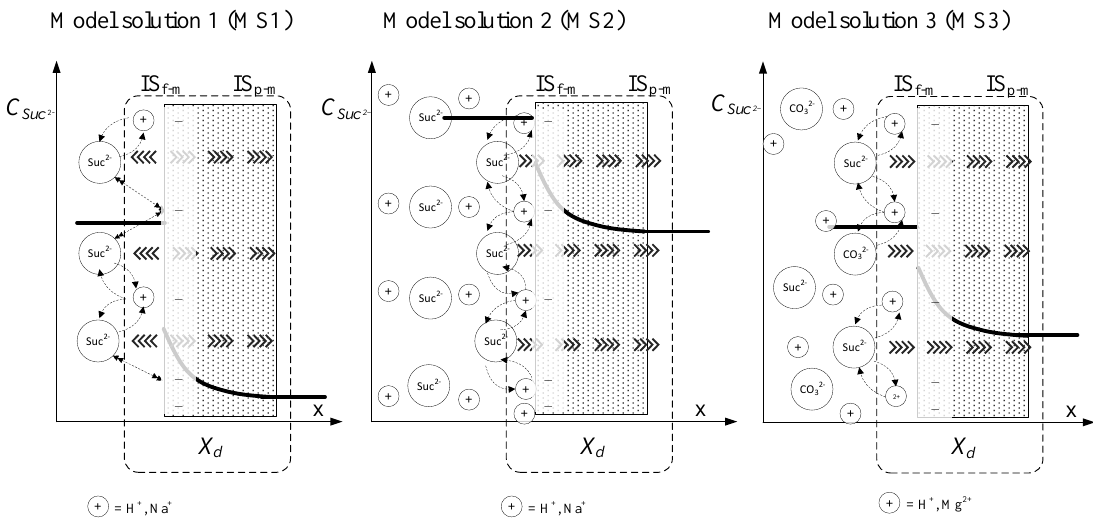
Figure 7. Schematic representation of separation mechanisms in nanofiltration of aqueous solutions of succinic acid with different pH regulators (for details about MS1, MS2, and MS3 see Table 4, X d —total volume membrane charge density; C suc2 − —molar concentration of succinate anion; IS f-m —feed-membrane interface; IS f-m —permeate-membrane interface).